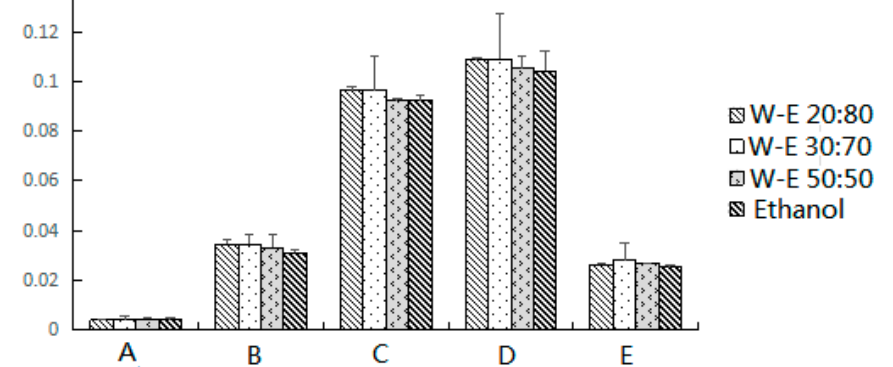
Figure 3. The effect of elution solvents on the extraction yields (%) of: Scopoletin (A); 2,4-Dihydroxy-6-methoxy-3-methylacetophenone (B); 17-Hydroxyjolkinolide B (C); Jolkinolide B (D); and Jolkinolide A (E), from E. fischeriana .